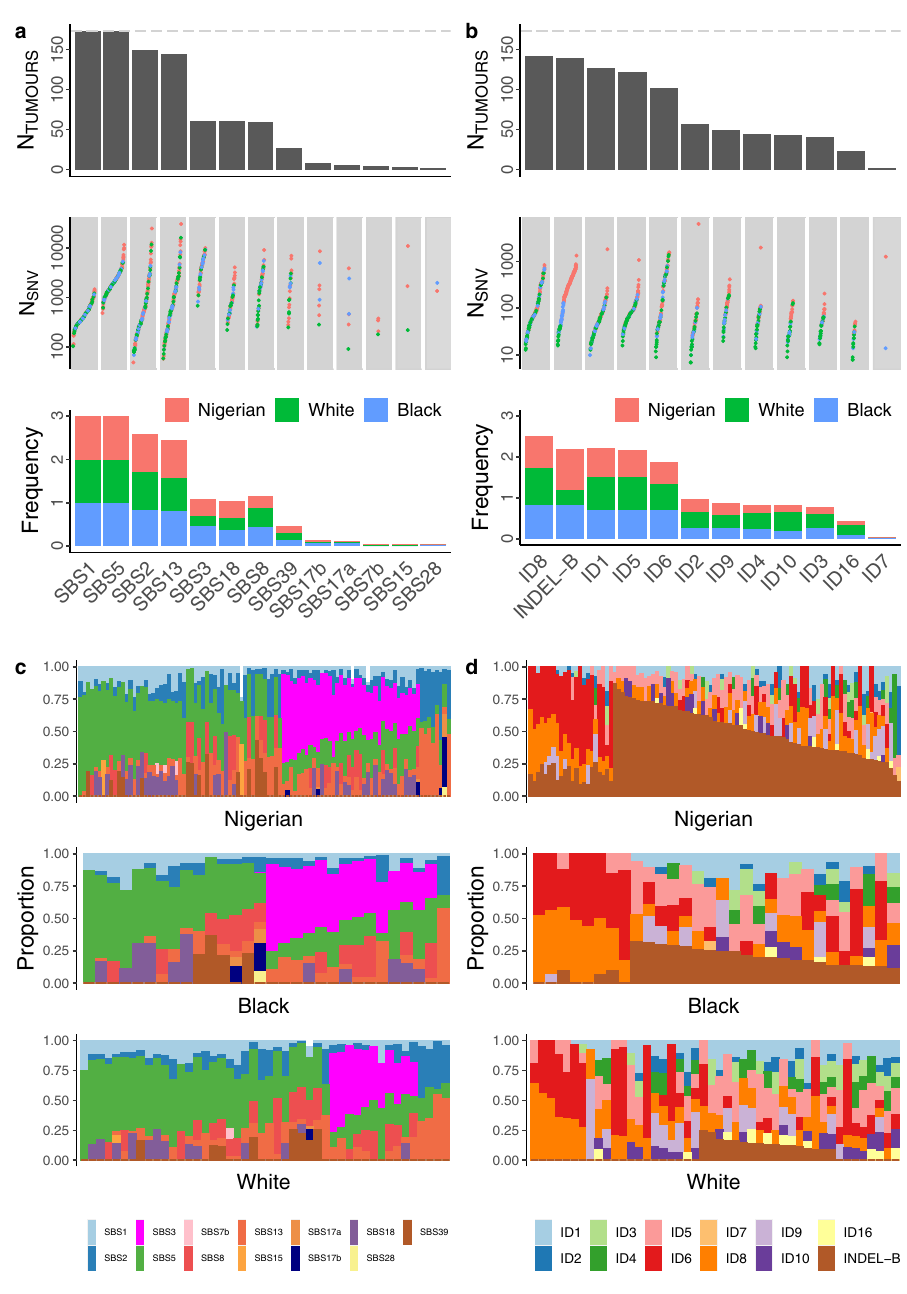
Fig. 3 Mutational signatures in breast cancer tumors across different ethnic groups. a , b Single-base substitution (SBS) signatures in all groups. a from top to bottom: number of tumors with SBS signatures across the entire dataset (the dotted line represents total sample size, n = 173) with signatures sorted left to right by descending frequency, number of mutations per sample (color representing groups) in respective signatures and proportion of samples carrying each signature in each group. b proportion of mutations assigned to each SBS signature across the three groups. c , d Identical plots as in a , b respectively for insertion/deletion (INDEL) signatures identi fi ed in the three groups. INDEL-B is a previously unreported signature characterized mainly by 5 + bp insertions. Source data are provided as a Source Data fi signature 28 . The rare SBS signatures (SBS17a/b, SBS7b, SBS15, was observed in similar frequencies across the groups (OR~1.3, and SBS28) were observed primarily in Nigerian and Black P > 0.58), DBS-B showed a higher contribution in Nigerians than groups, with the mean prevalence of these signatures at 2.8 and in the White (1.55-fold, P = 0.0035) and Black (1.42-fold, 3.3%, respectively. The HRD signature SBS3 was observed in all P = 0.018) groups. groups. However, compared with the White group, the Black Twelve INDEL signatures were detected, of which ID8 and (OR = 2.74, P = 0.048) and Nigerian (OR = 1.87, P = 0.13) INDEL-B were the most frequent. Of note, previously groups had slightly higher activity. Nine double-base substitution unreported signature INDEL-B was not only signi fi cantly (DBS) signatures were also identi fi ed, of which fi ve were pre- depleted in the White group compared with the Nigerian viously unreported (Supplementary Fig. 12). Although DBS-B ( P = 1.1 × 10 − 18 ) and the Black groups ( P = 1.2 × 10 − 4 ), but it